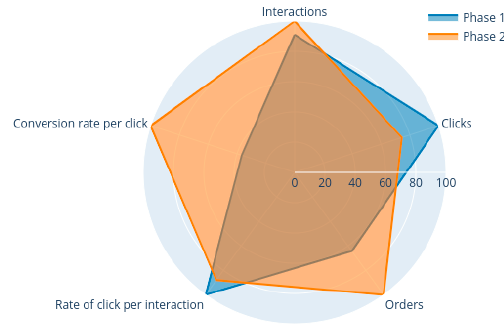
b . Average efficiency for each influencer in each phase. Figure 9. The average influencer Figure 9. The average influencer efficiency.